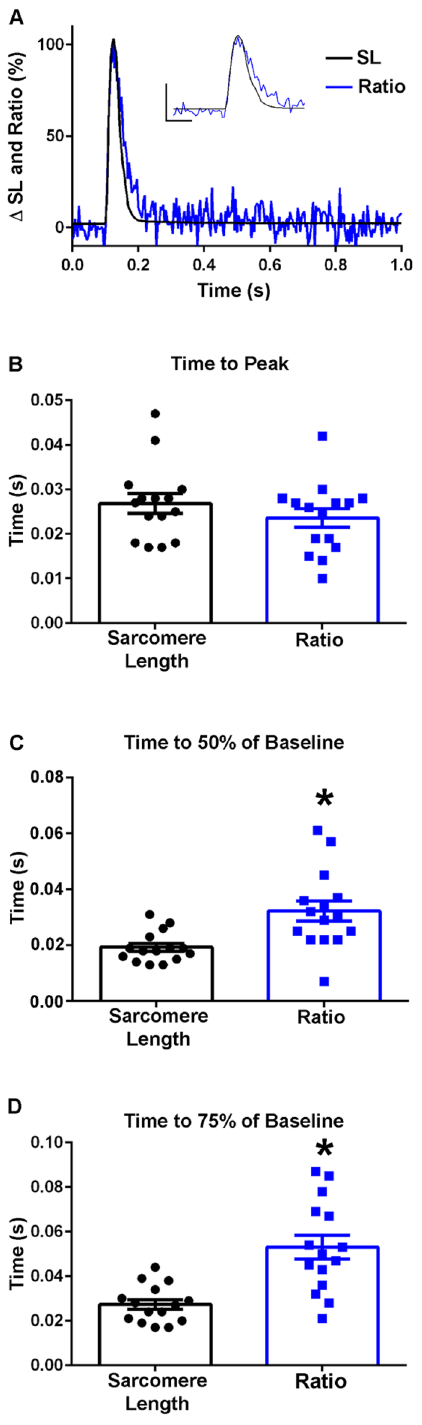
Figure 6. TnC biosensor transient in intact FDB myofibers at 37 °C. ( A ) Normalized traces (0–100%) of an ensemble average of biosensor ratio fluorescence (blue) and sarcomere length (black) dynamics. Inset shows same data and serves to highlight the region of the peak amplitude (y-axis represents a 50% change from baseline, x-axis represents 0.05 s). ( B ) Summary statistics for time to peak for the biosensor ratio and sarcomere length shows timing of the peak activation of the biosensor ratio is not significantly different from the time to peak of the sarcomere length (n = 15 myofibers in each group from n = 7 animals). ( C ) Summary statistics for the time to 50% of baseline for the biosensor ratio and sarcomere length demonstrate that biosensor inactivation (0.0323 ± 0.0036 s) was delayed relative to the relaxation of the myofiber (0.0193 ± 0.0014 s) (n = 15 myofibers in each group from n = 7 animals). ( D ) Summary statistics for the time to 75% of baseline for the biosensor fluorescence ratio and sarcomere length showed a significant difference in the relaxation dynamics of the biosensor and sarcomere length, with the biosensor inactivation (0.0530 ± 0.0053 s) slower than the sarcomere length relaxation of the myofiber (0.0274 ± 0.0022 s) (n = 15 myofibers in each group from n = 7 animals). Myofibers measured at 37 °C with 0.2 Hz stimulation. Mean ± S.E.M. are presented, * P <